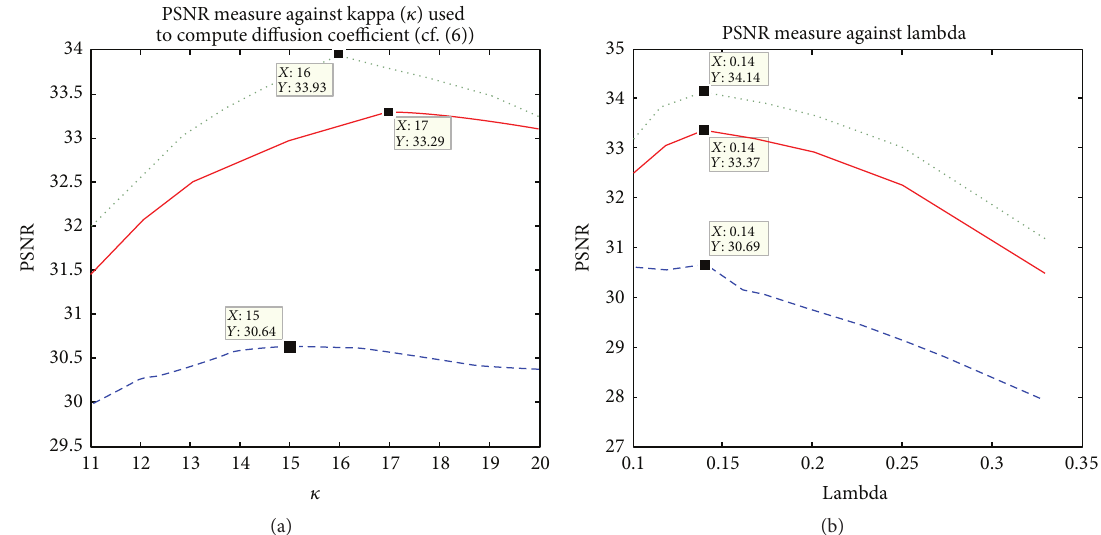
Figure 19: Results show two graphical plots: (a) measures the change of PSNR values against the parameter kappa ( 𝜅 ) (cf. in (4)) used to compute the diffusion coefficient ( 𝐶 𝑛 ), which reflects an optimum value in the range of 15 to 17 needed to obtain the denoised accuracy as shown with the pointers in the graphs. (b) shows a single value for 𝜆 = 1/7 yields the maximum denoised output for different images of varying resolutions; the rest of the filter settings remain the same.